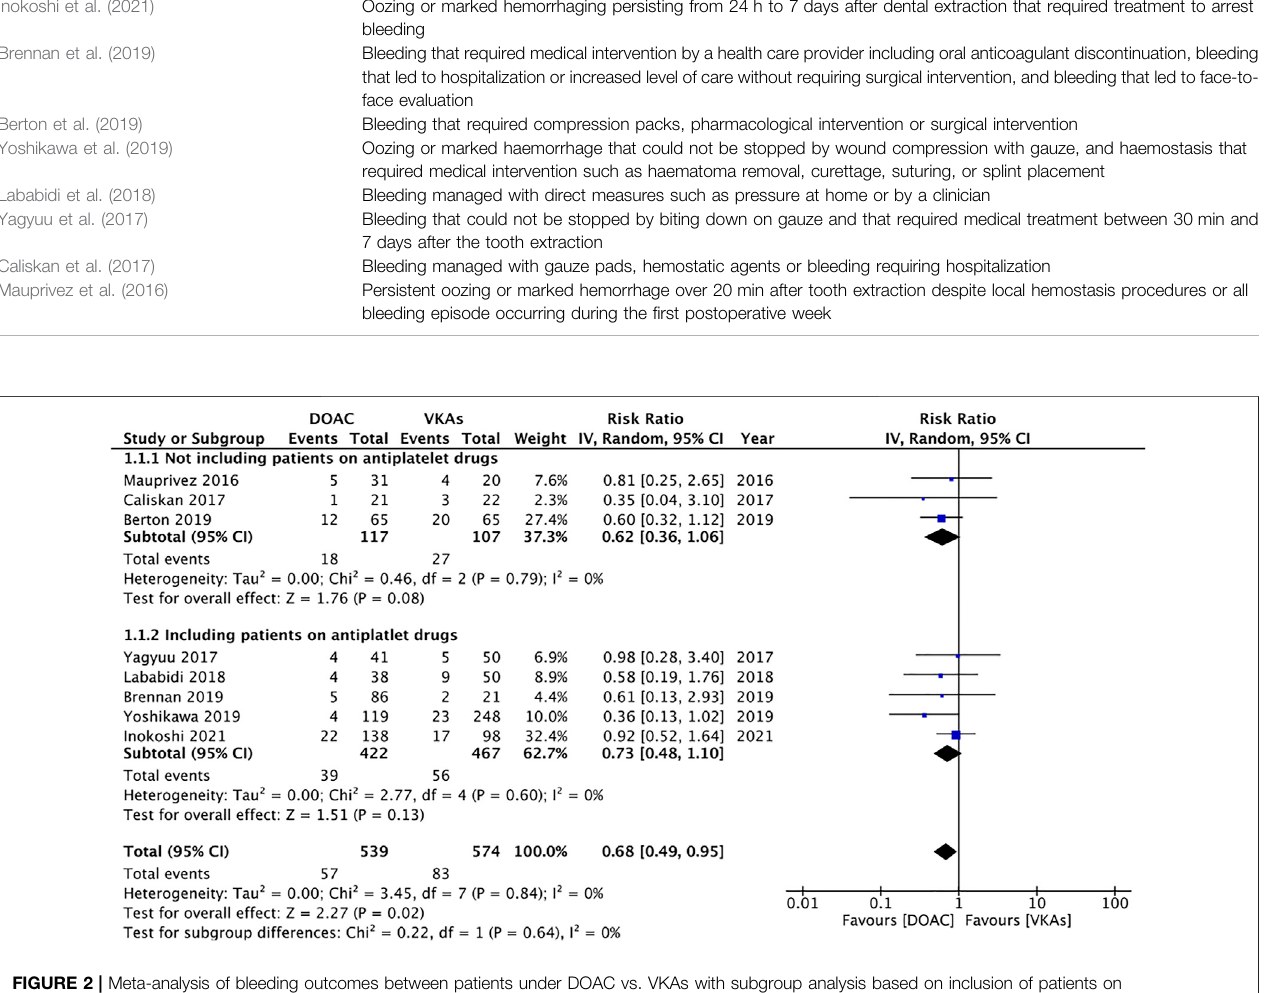
Frontiers in Pharmacology |